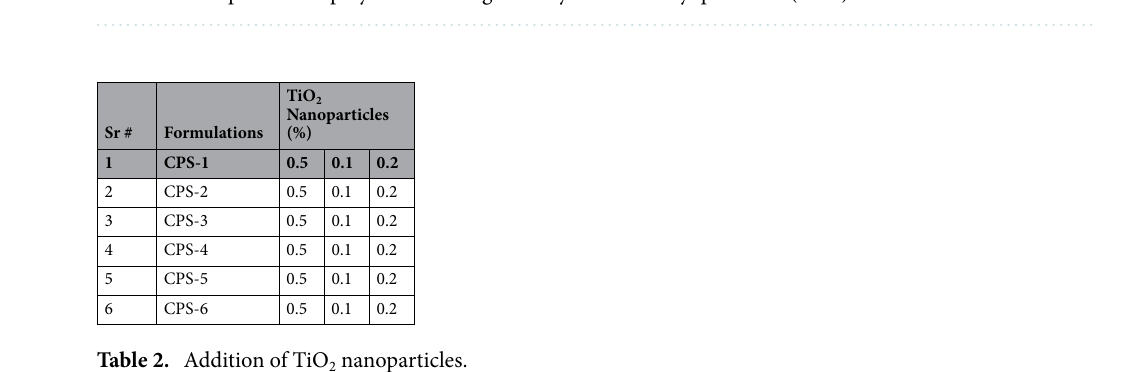
Table 1. Composition of polymeric coatings. Catalyst: Di.ter.butyl peroxide :(0.5%).